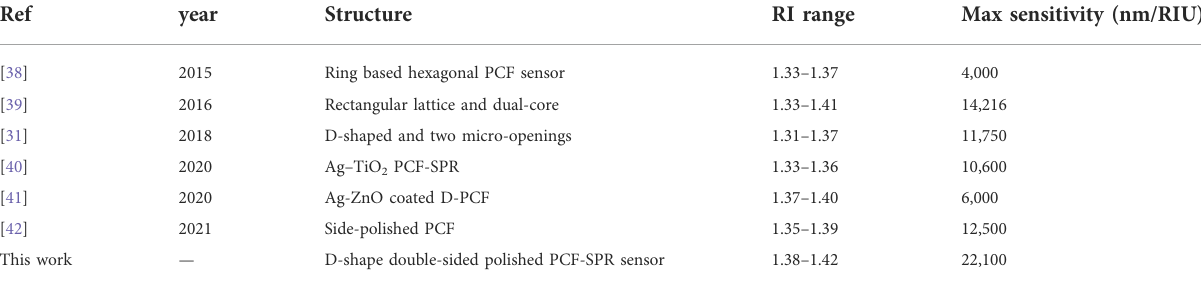
TABLE 1 Performance comparison of the proposed sensor with other recent reported PCF